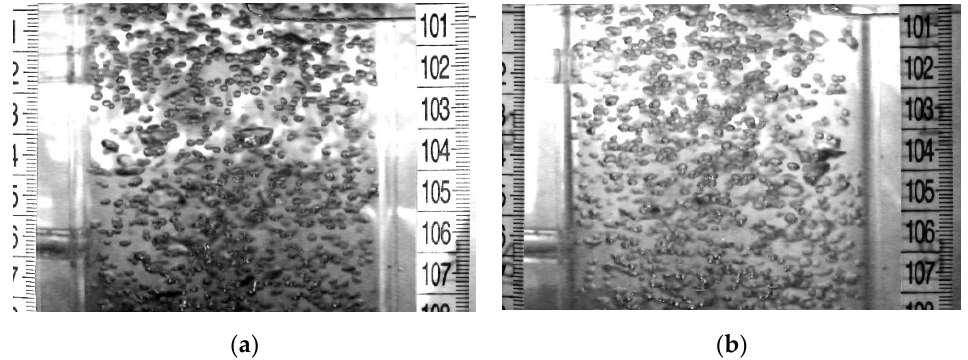
Figure 6. Images of the bubbles captured in UFC and PFC: ( a ) Bubbles in UFC; ( b ) Bubbles in